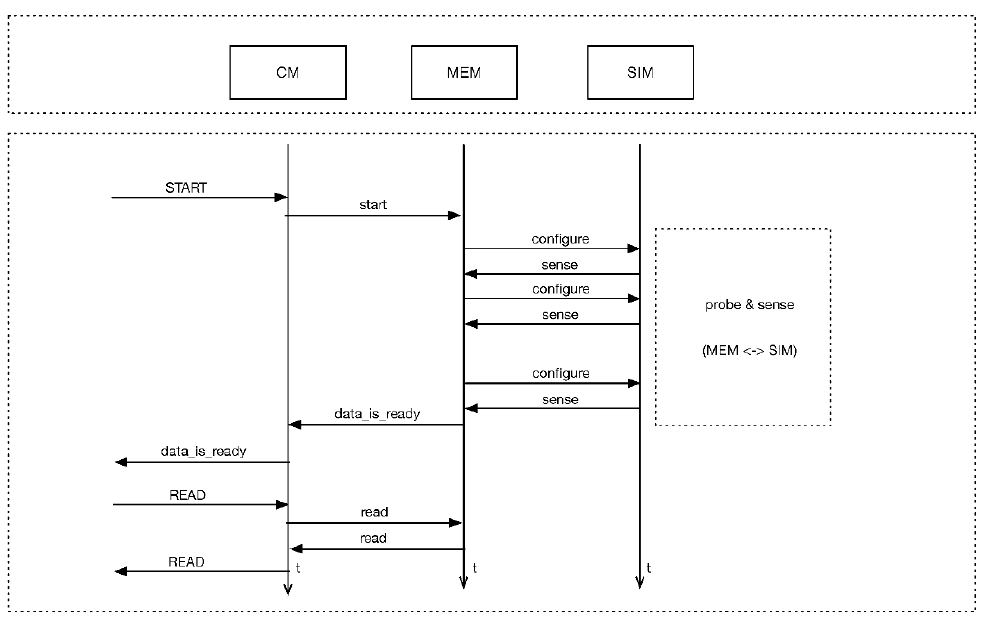
Figure 2. Smart Sensor for Cyclic